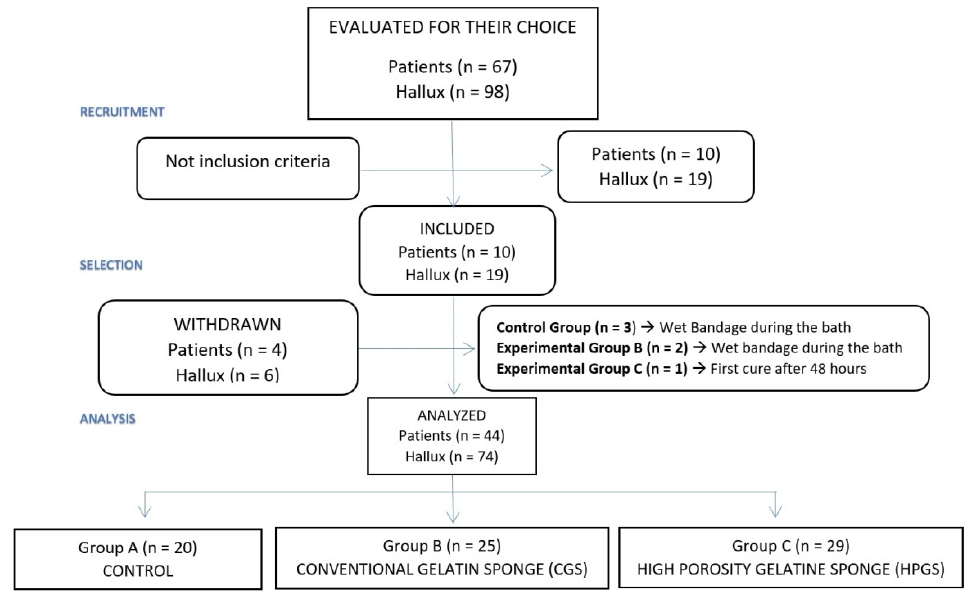
Figure 1. Flow chart of the patients .